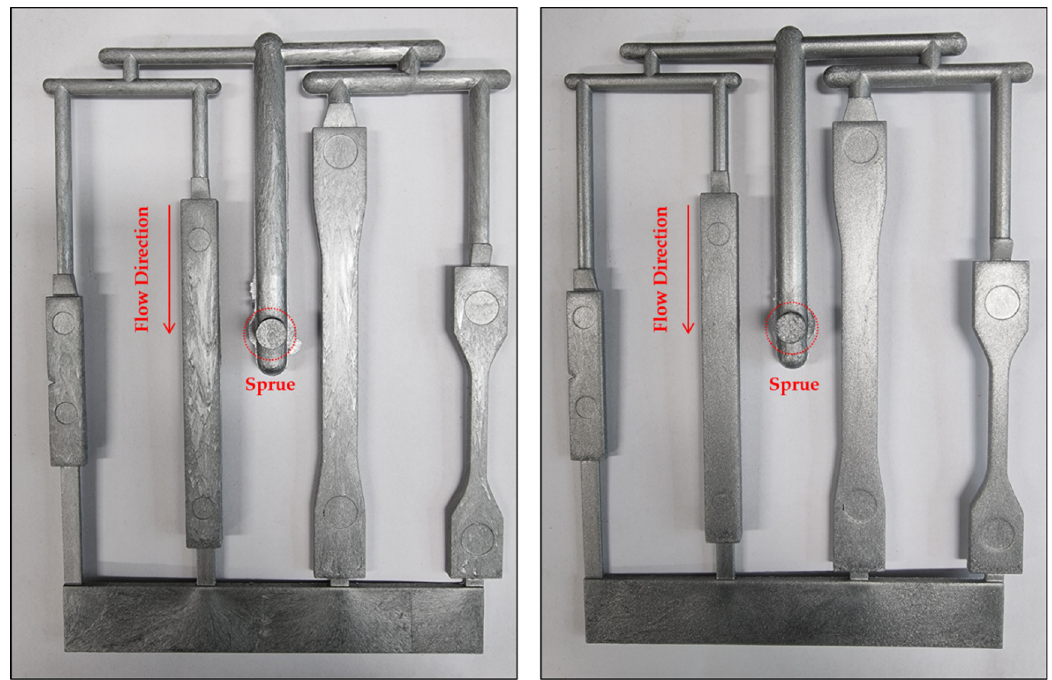
Figure 4. Comparison of the appearance of foam injection products produced with different sized of aluminum flakes: 13 μ m ( left ), 65 μ m ( right ).